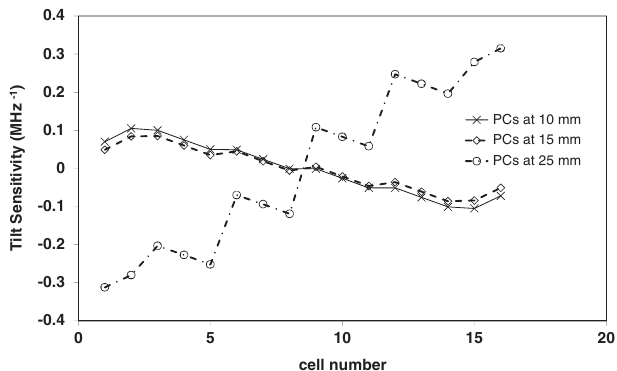
FIG. 24. Tilt sensitivity of perturbed fields as calculated by the equivalent circuit. Each curve is associated to a different value of the gap PC-DT.